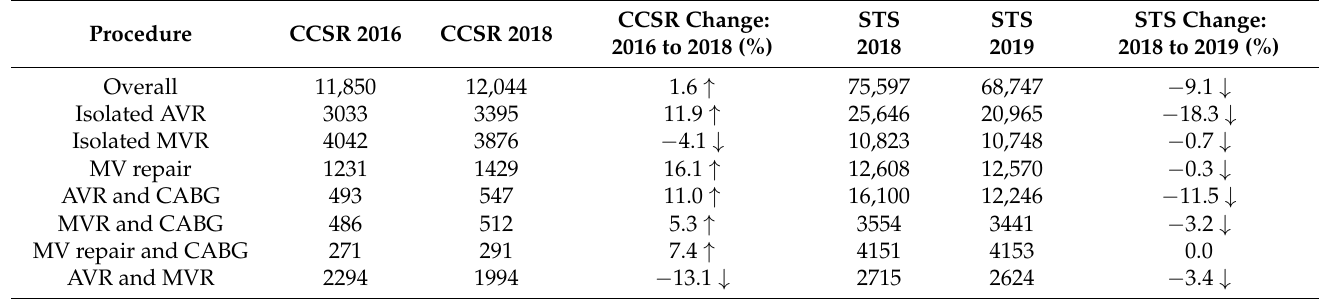
Table 1. Change in procedure volume in CCSR data from 2016 to 2018 and in STS data from 2018 to 2019.